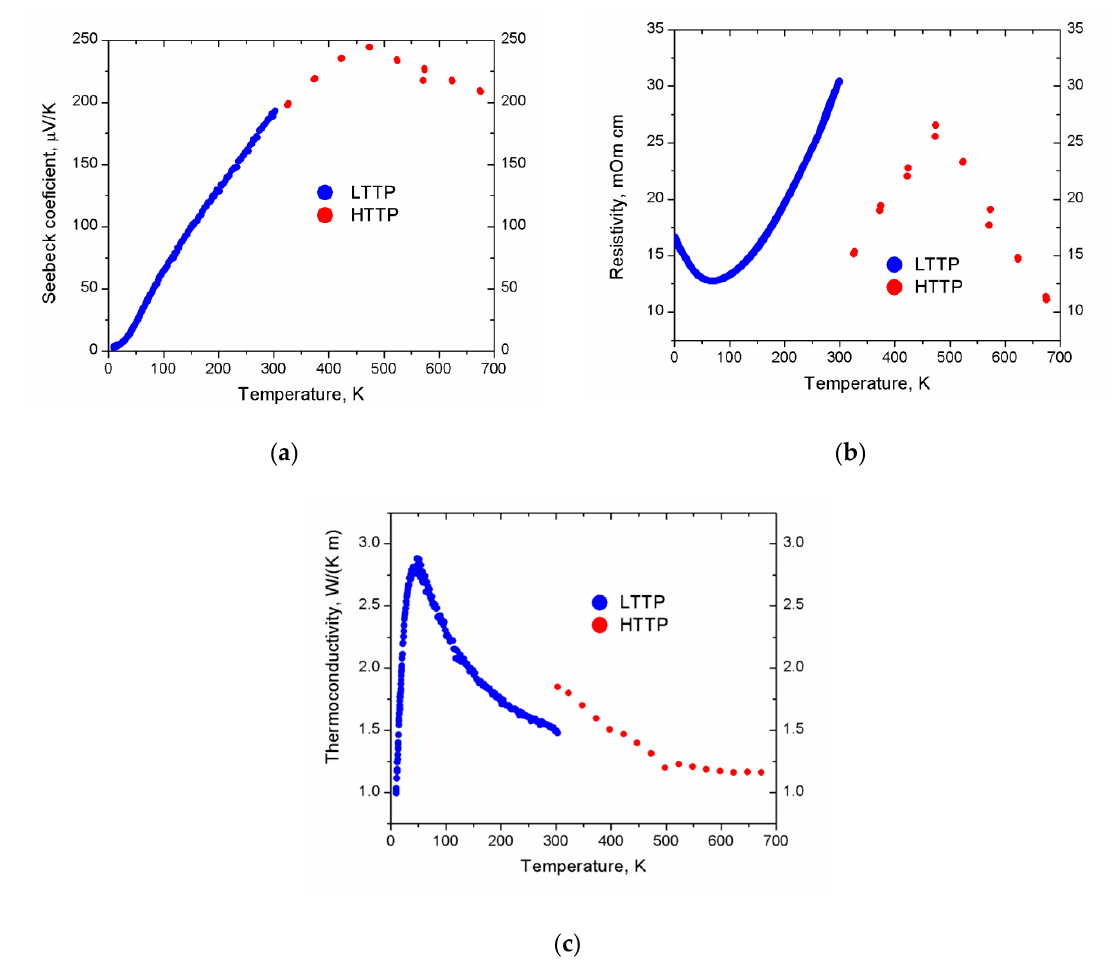
Figure 6. Temperature dependence of transport for NaZnSb: ( a ) Seebeck coefficient, ( b ) electrical resistivity, ( c ) total thermal conductivity (the estimated electronic thermal conductivity contribution is negligible, less than 2%, and is not shown). The low-temperature thermoelectric properties (LTTP) data are shown in blue, while the high-temperature thermoelectric properties (HTTP) data are shown in red. The discontinuity between LLTP and HTTP is due to the different instruments used for the measurement.